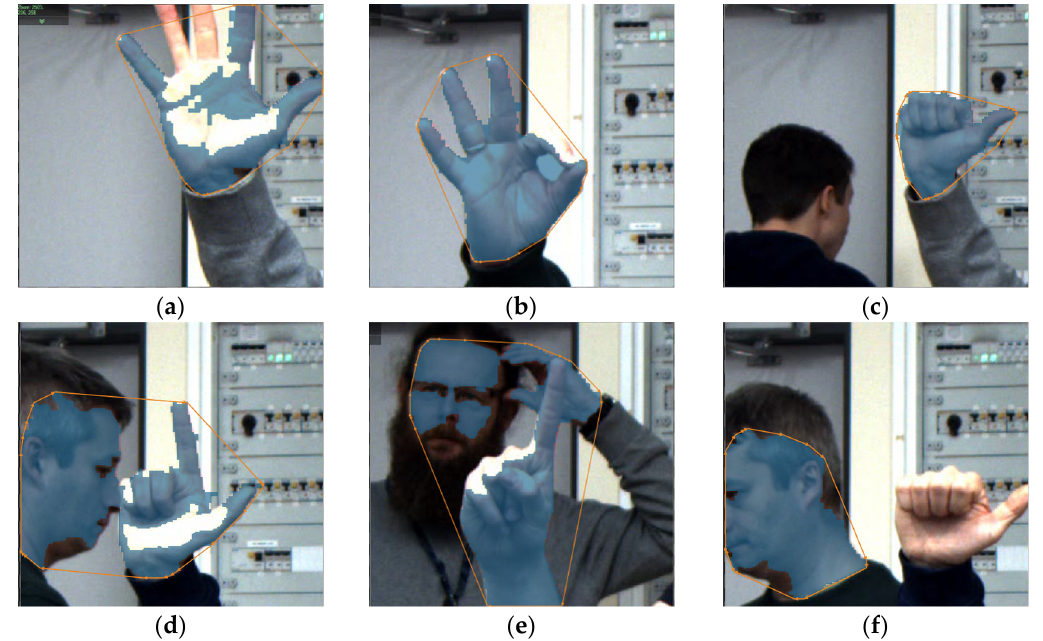
Figure 9. Images of di ff erent gestures and faults.